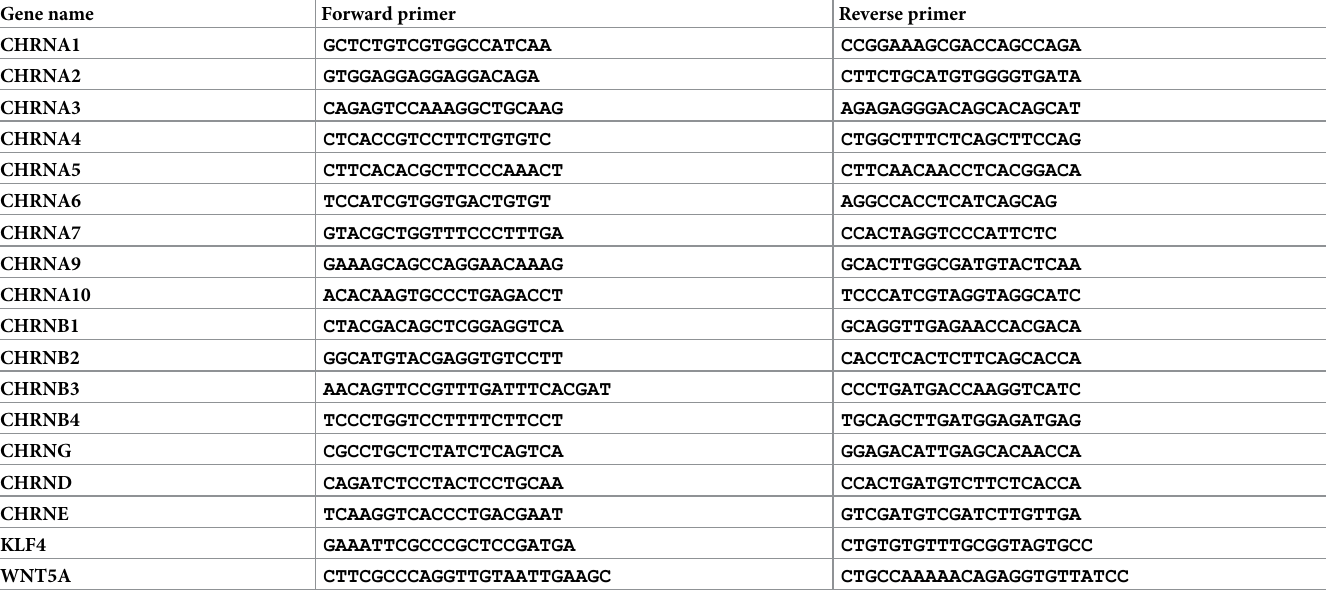
Table 1. The real-time PCR primers